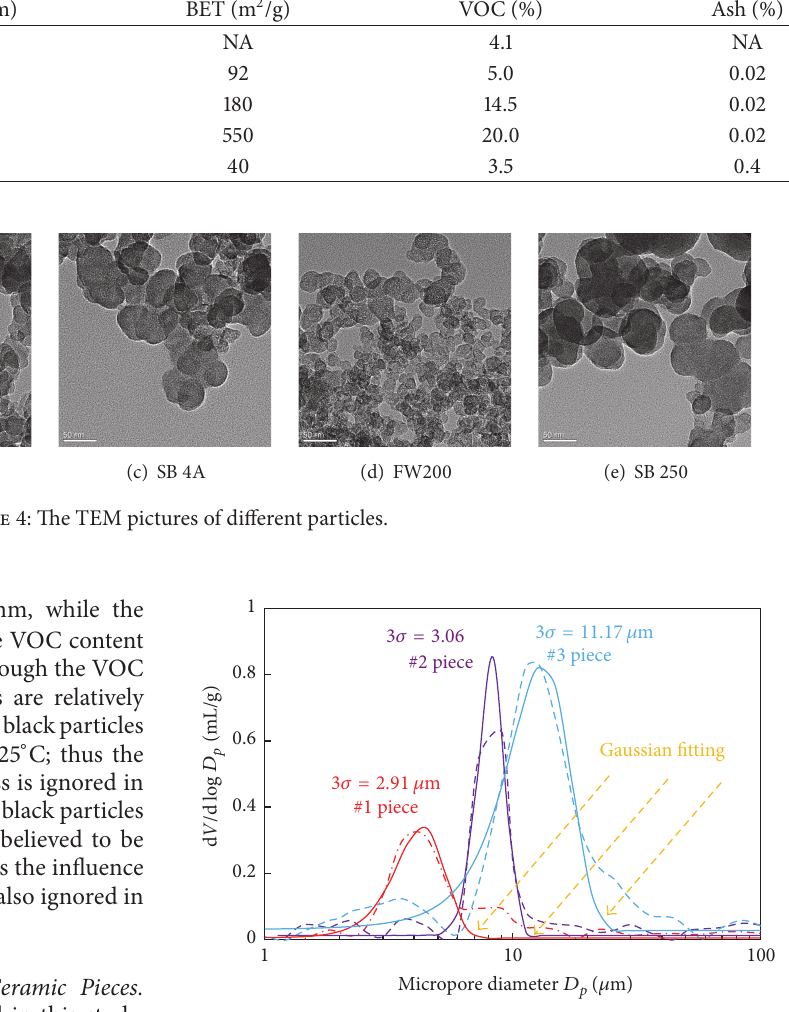
Figure 5: Gaussian fitting of tested ceramic